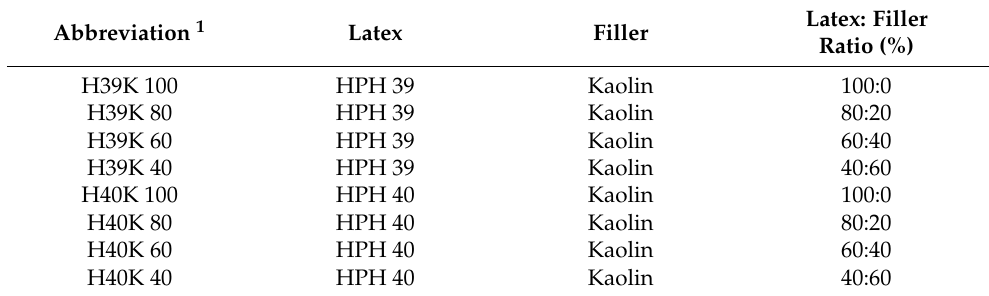
Table 2. Experimental coating formulations for HPH 39 and HPH 40 styrene-butadiene